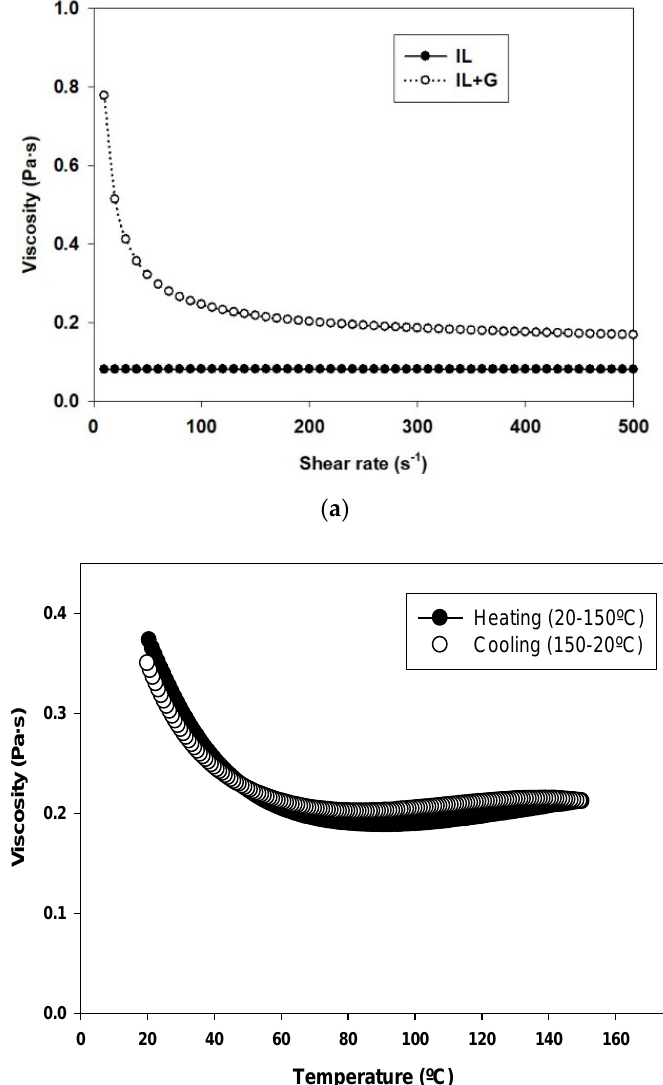
Figure 2. ( a ) Viscosity vs. shear rate at 25 °C; ( b ) viscosity vs. temperature for (IL + G) dispersion.